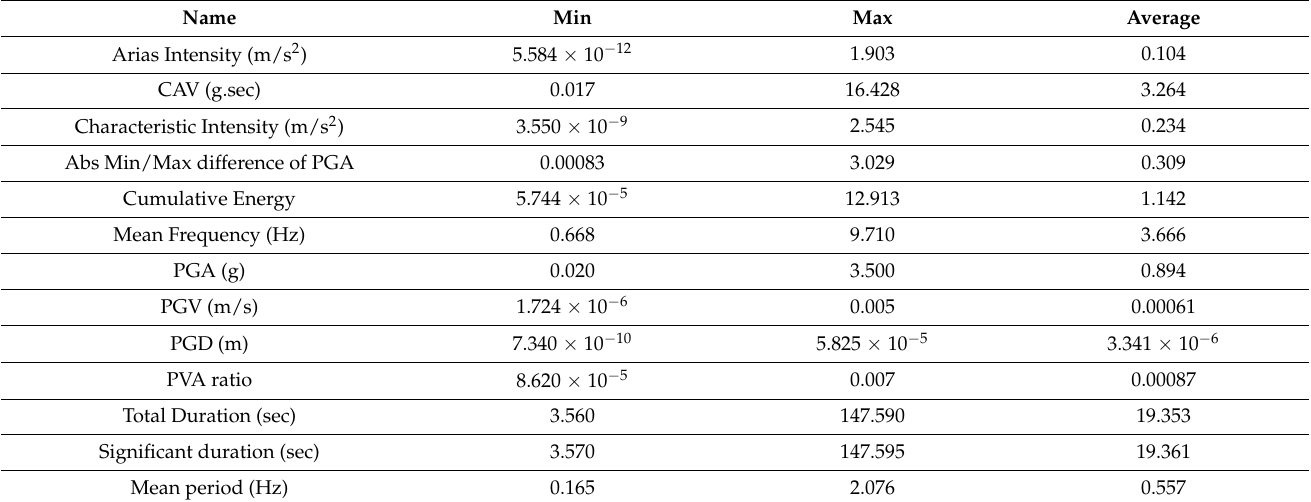
Table 1. The 13 seismic wave features with the statistical analysis.